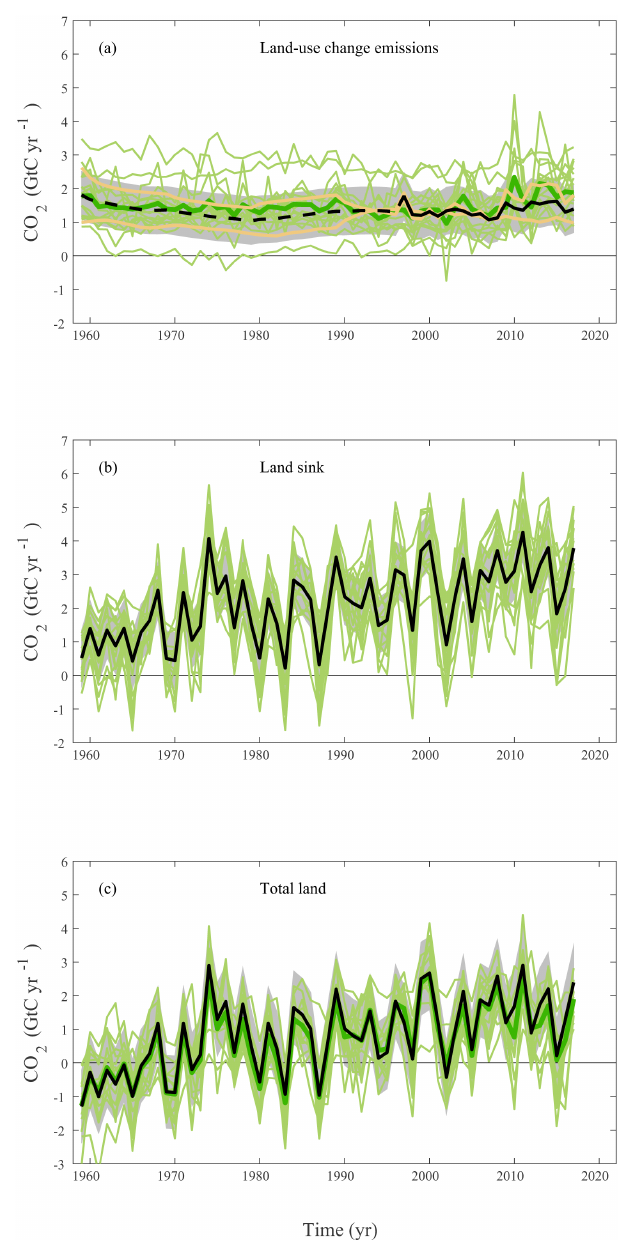
Figure 6. CO 2 exchanges between the atmosphere and the terres- trial biosphere as used in the global carbon budget (black with ± 1 σ uncertainty in grey shading), for (a) CO 2 emissions from land-use change ( E LUC ), also individually showing the two bookkeeping models (two brown lines) and the DGVM model results (green) and their multi-model mean (dark green). The dashed line identi- fies the pre-satellite period before the inclusion of peatland burn- ing. (b) Land CO 2 sink ( S LAND ) with individual DGVMs (green); (c) total land CO 2 fluxes (b–a) with individual DGVMs (green) and their multi-model mean (dark green).